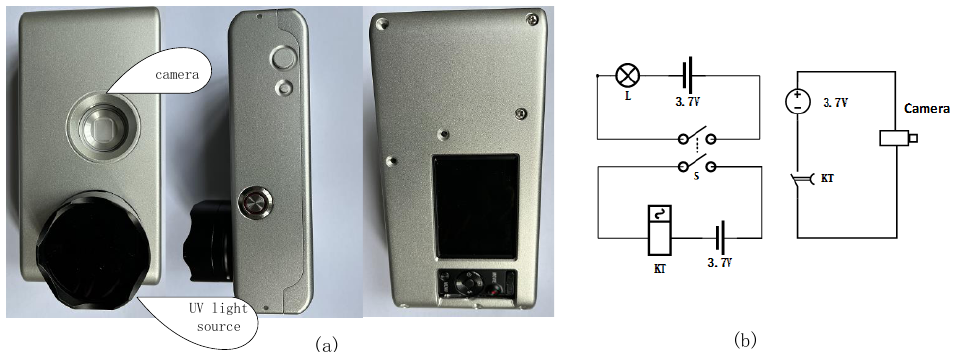
Figure 3. Device designed to acquire fluorescent images: ( a ) the appearance of the device; ( b ) simpli- fied circuit diagram.